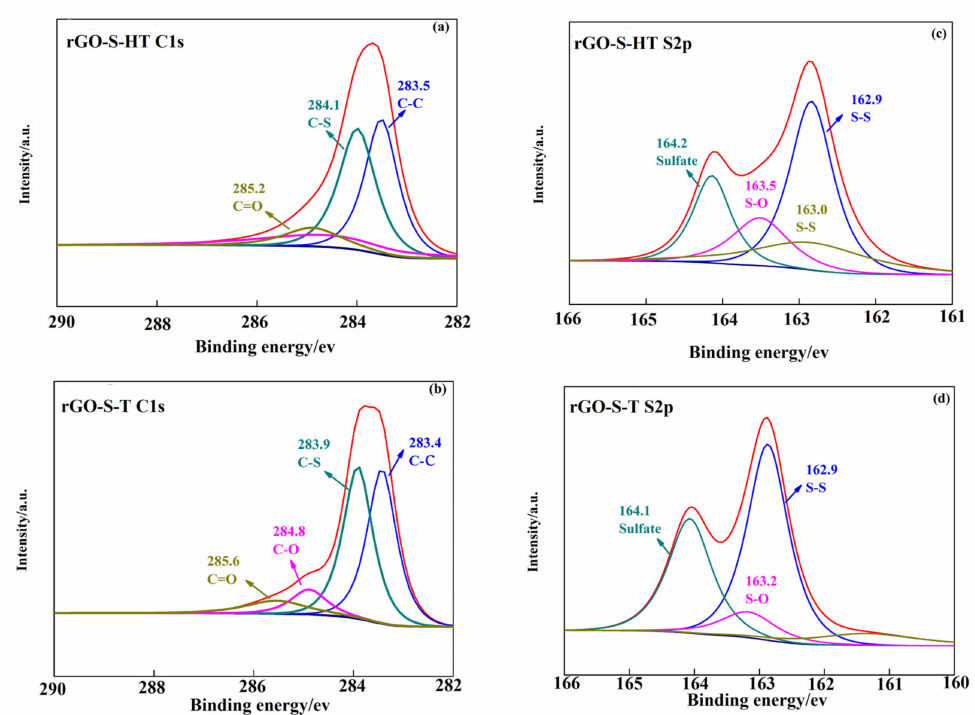
Figure 4. ( a , b ) C1’s signal obtained from XPS spectra of rGO-S-HT and rGO-S-T, ( c , d ) S 2p XPS spectra of rGO-S-HT and